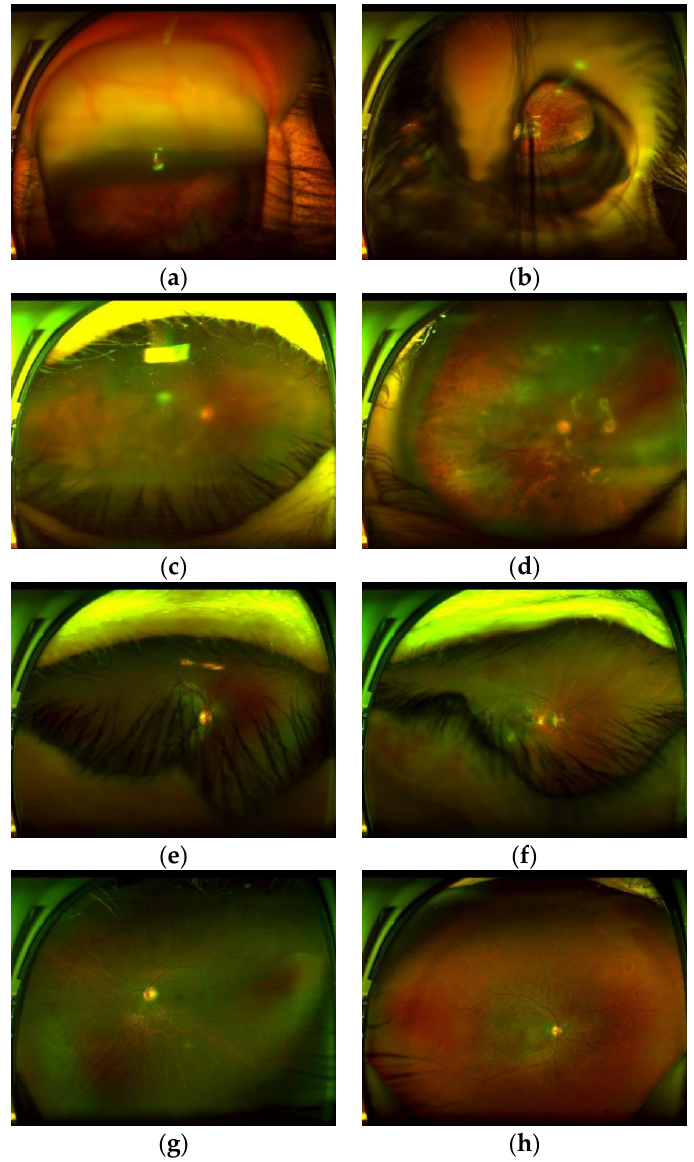
Figure 1. Several low-quality images and high-quality images taken by the SLO. ( a , b ) outlier images, ( c , d ) blurred images, ( e , f ) images with obstruction by eyelash, ( g , h ) high-quality images.